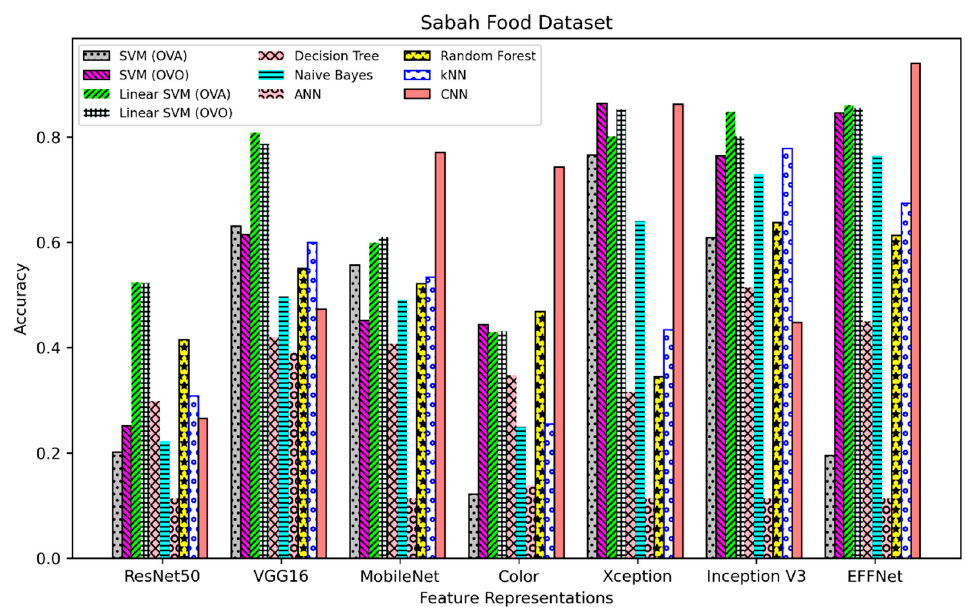
Figure 3. A comparison of the performance of six feature representations and ten classifiers on the Sabah Food Dataset.